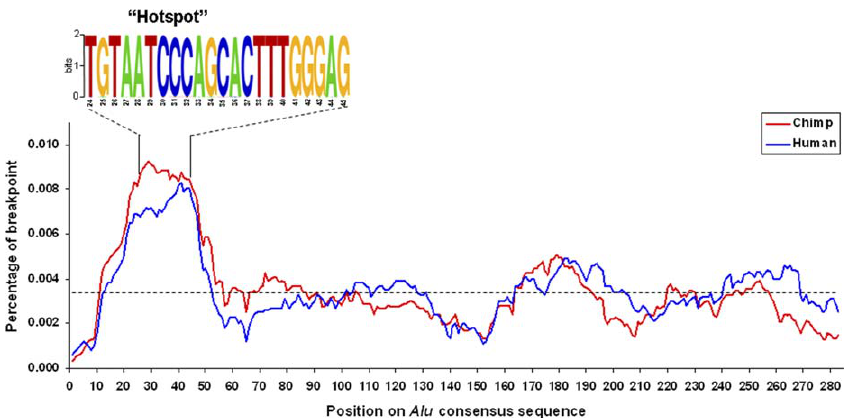
Figure 4. Recombination Breakpoints during Chimpanzee-Specific ARMD Events Percentage of ARMD events found to have breakpoints at different positions along an Alu consensus sequence. The ‘‘ hotspot ’’ region is represented by a conserved 22-bp nucleotide sequence found in 634 ARMD loci (the first and second types of ARMD events) using WebLogo analysis (http://weblogo. berkeley.edu). The dashed line represents the average percentage (0.0035%) of breakpoints across the entire length of the Alu consensus sequence.